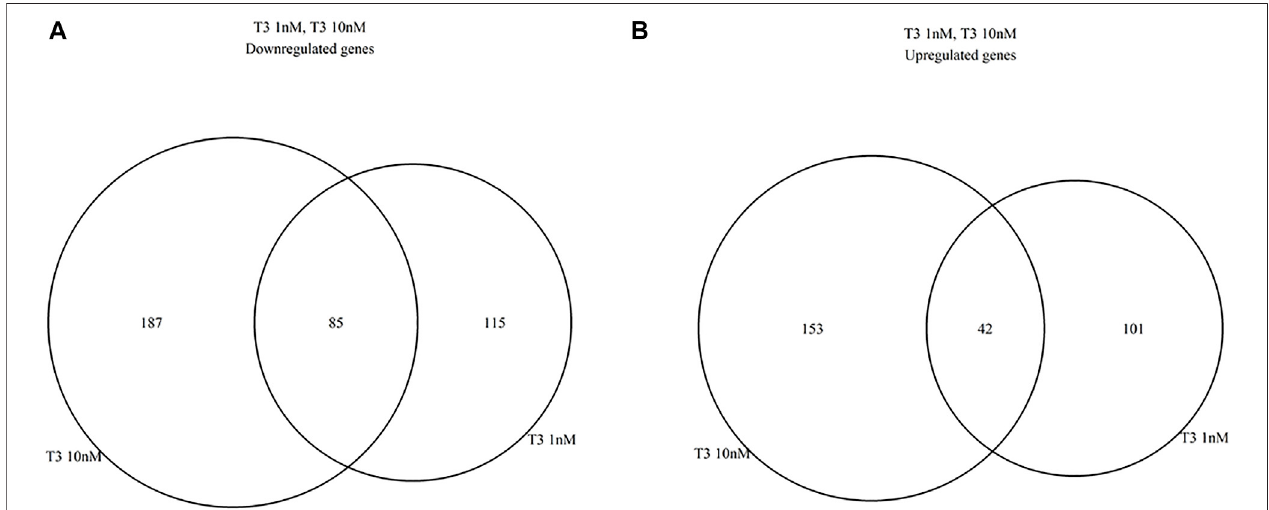
FIGURE 3 | Venn diagrams summarizing similarities between 1 and 10 nm T3 expression pro fi les, relative to the Control group; (A) , dowregulated genes, (B) upregulated genes.